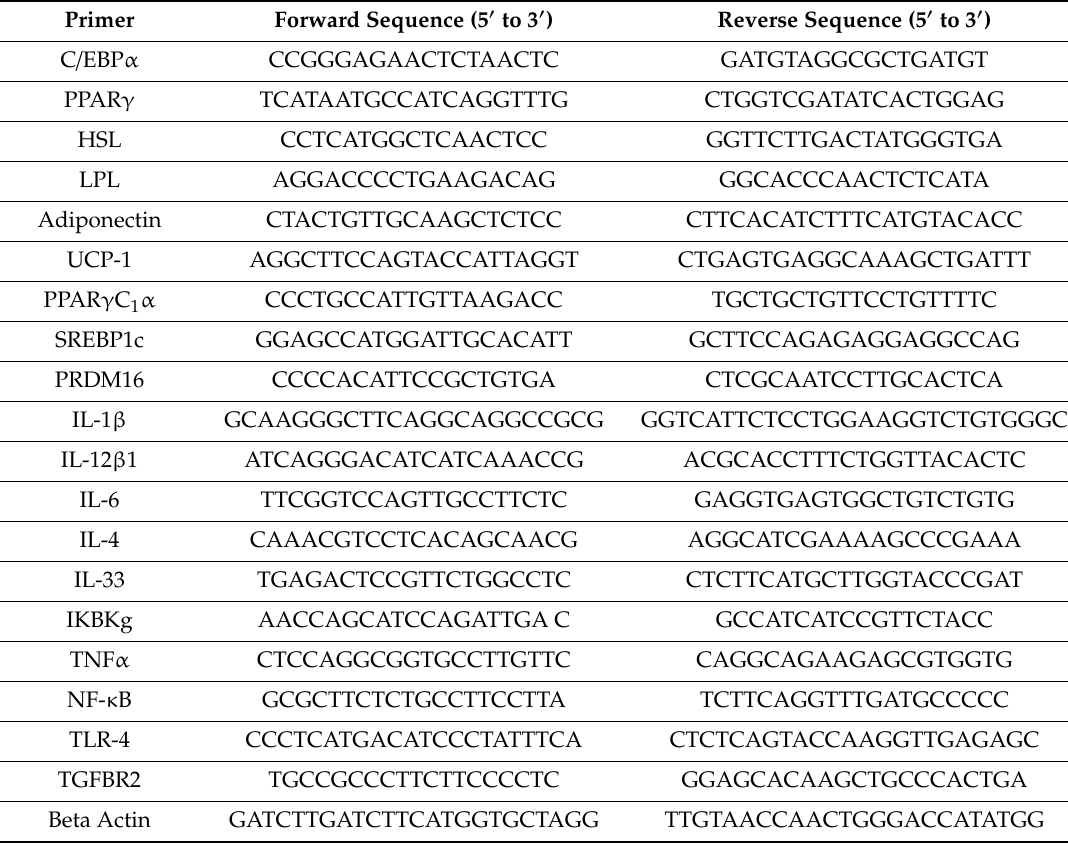
Table 1. Primers sequence used in the Sybrgreen based real-time